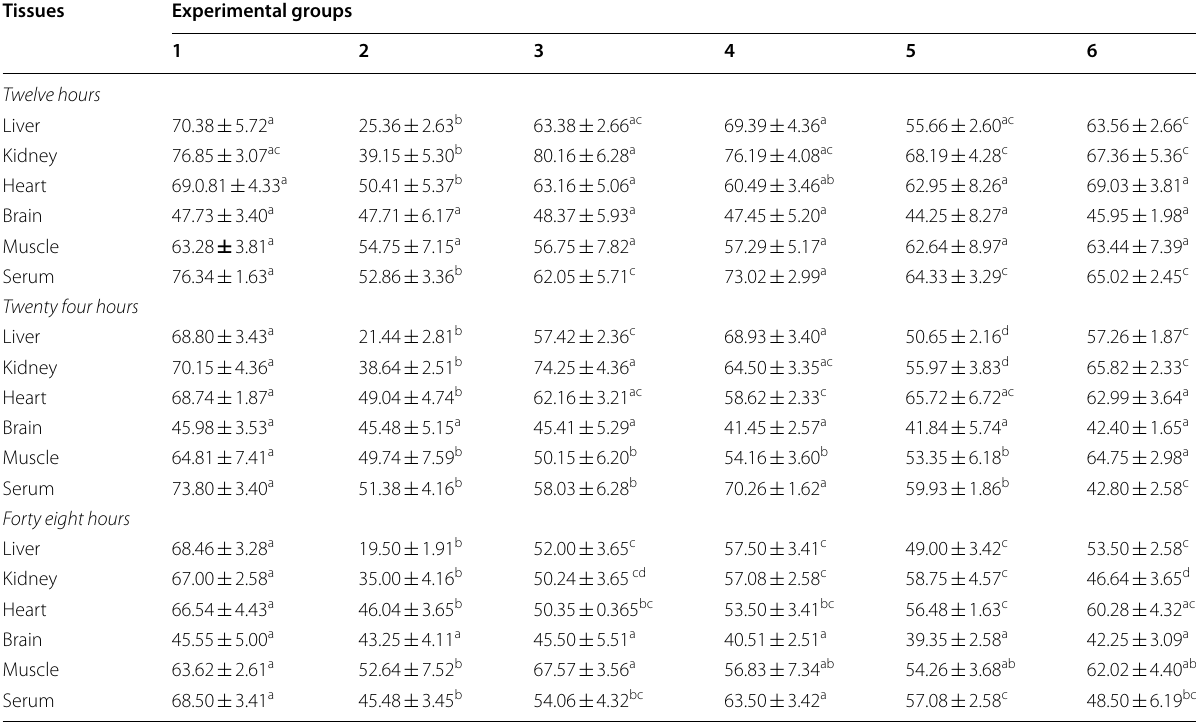
Tissues Experimental